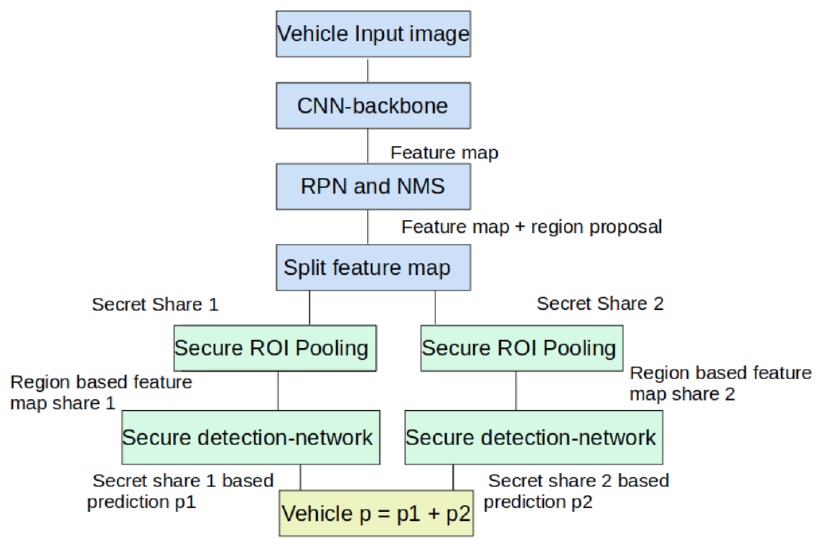
Figure 2. Structure and major components of vePOD Faster R-CNN. Blue blocks represent the operations performed on a vehicle and green blocks are those executed on an edge server; the yellow block can be done on the same or a different